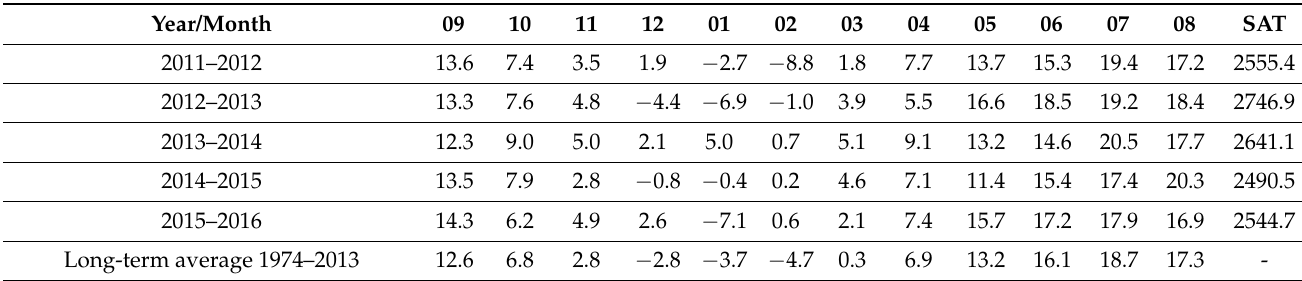
Table 3. Average temperature ( ◦ C) and the sum of the active temperatures (SAT) during the winter rye growing season (September–August) in 2011–2016, Kaunas Meteorological Station.